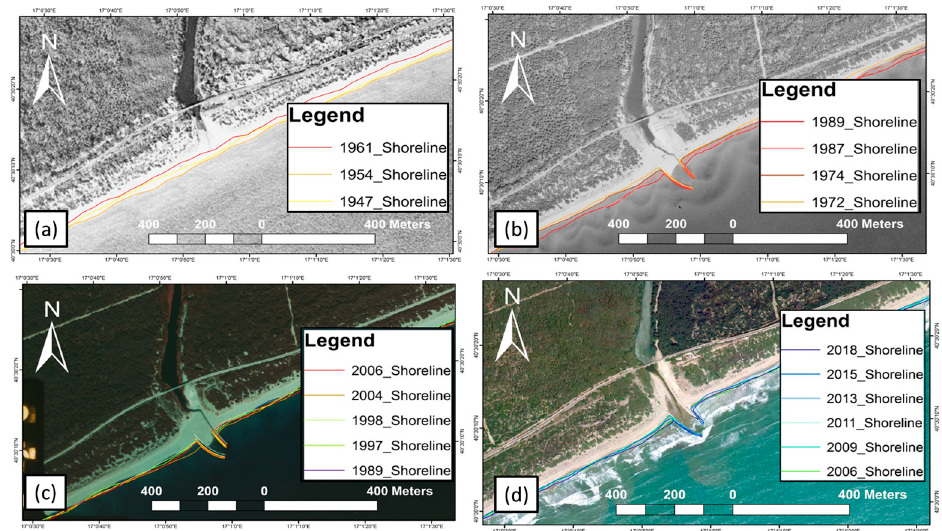
Figure 13. Shoreline changes close to the Lenne River mouth: ( a ) 1954 basemap with 1947–1961 super-imposed shorelines; ( b ) 1974 basemap with 1972–1989 super-imposed shorelines; ( c ) 1989 basemap with 1989–2006 super-imposed shorelines; and ( d ) 2013 basemap with 2006–2018 super-imposed shorelines.